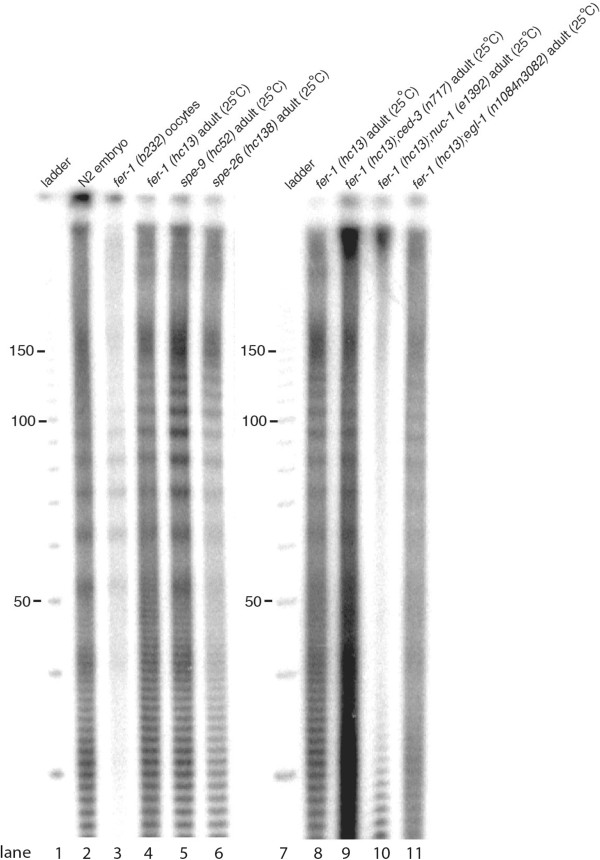
Genetic requirement for the DNase activity present in unfertilized oocytes. Genomic DNA extracted from purified oocytes ('fer-1 oocytes’) or from liquid-nitrogen-flash-frozen samples (N2 (wild type) embryos and adults of various genotypes) was radioactively-labeled using T4 polynucleotide kinase and gamma-32P-ATP, and resolved on a denaturing 12% polyacrylamide gel (8 M urea). A total of 2 μg of DNA were used for labeling and PAGE analysis for all samples except DNA from isolated fer-1(b232) oocytes (<30 ng).